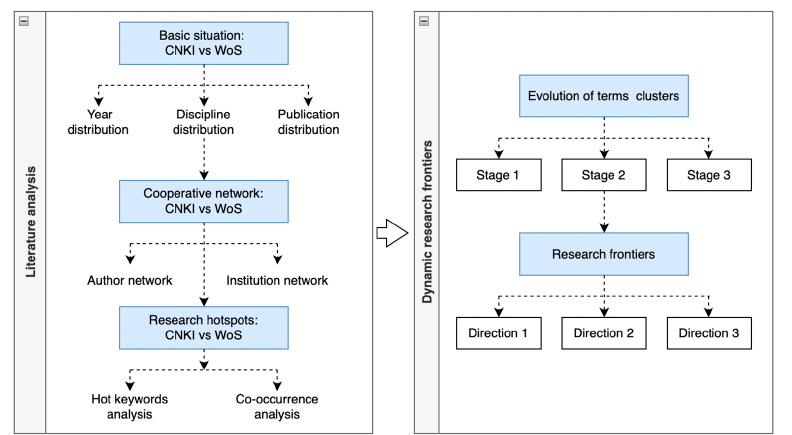
Figure 1. The process of this research.